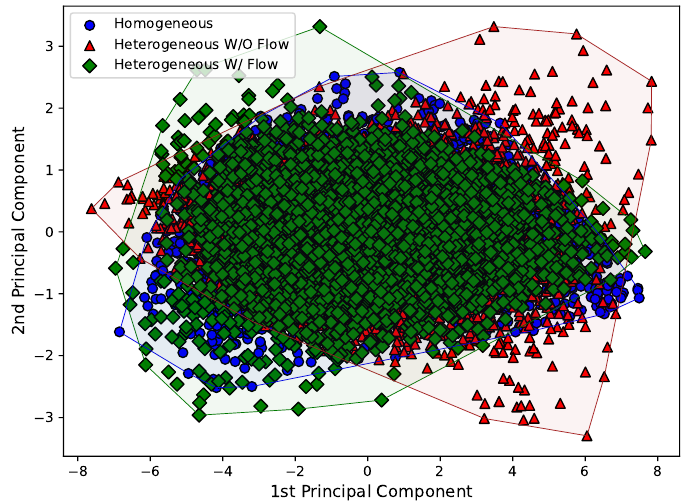
Figure 10. First and second principal components for the complexity Hjorth parameter considering all the eight